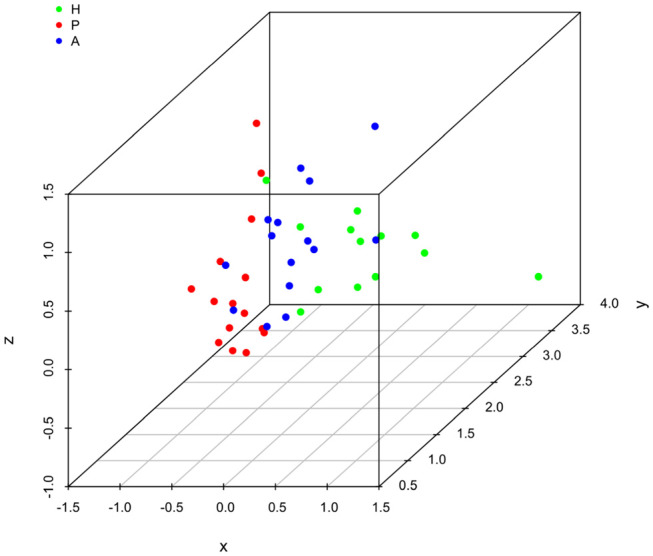
Principal component analysis (PCA) plot for profiles of specialized pro-resolving lipid mediator (SPM) receptor gene expression in human gingiva. One dot represents one sample in each group. This plot demonstrates clusters of samples based on their similarity of receptor gene expression. (H (green): healthy; P (red): periodontitis before non-surgical therapy; A (blue): periodontitis after non-surgical therapy).